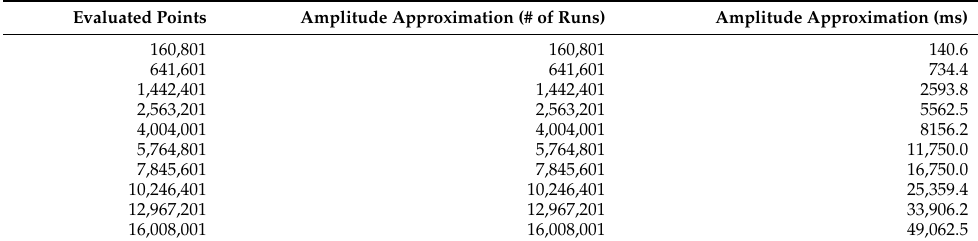
Table A5. Measurement results without pre-filtering with 1 receiver.